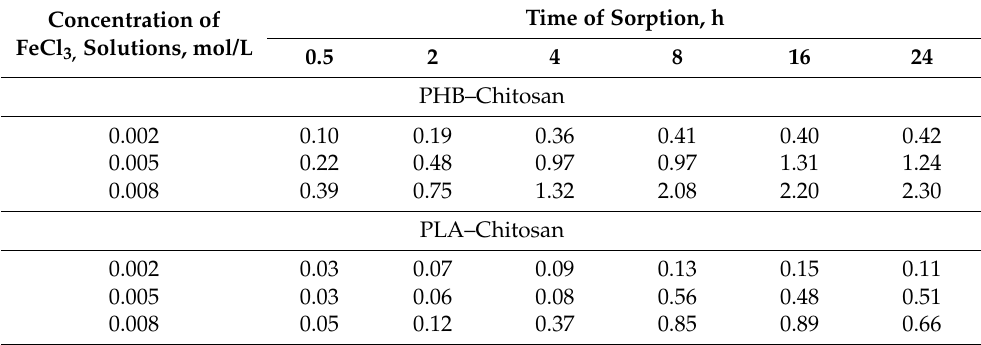
Table 1. The concentration of sorbed Fe 3+ ions (wt. %) by the film compositions PHB–chitosan (50:50) wt. % and PLA–chitosan (50:50) wt. %. Concentration of FeCl 3, Solutions, mol/L